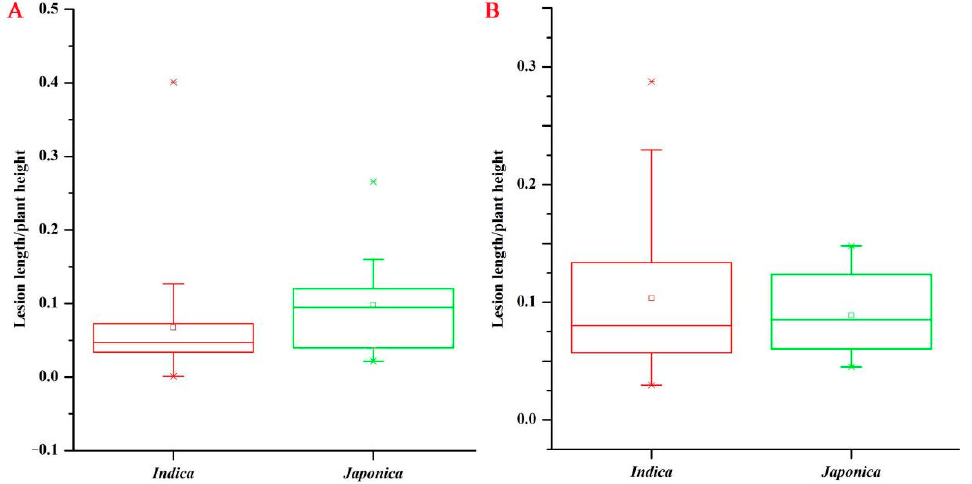
Figure 2. Evaluation of ShB resistance (lesion length/plant height) in indica and japonica in two years. ( A ) Lesion length/plant height in 2016; ( B ) lesion length/plant height in 2017. Table 1. Summary of association mapping results for sheath blast resistance using EMMAX. Number of Significant Loci ( − log 10 ( p ) > Chr.